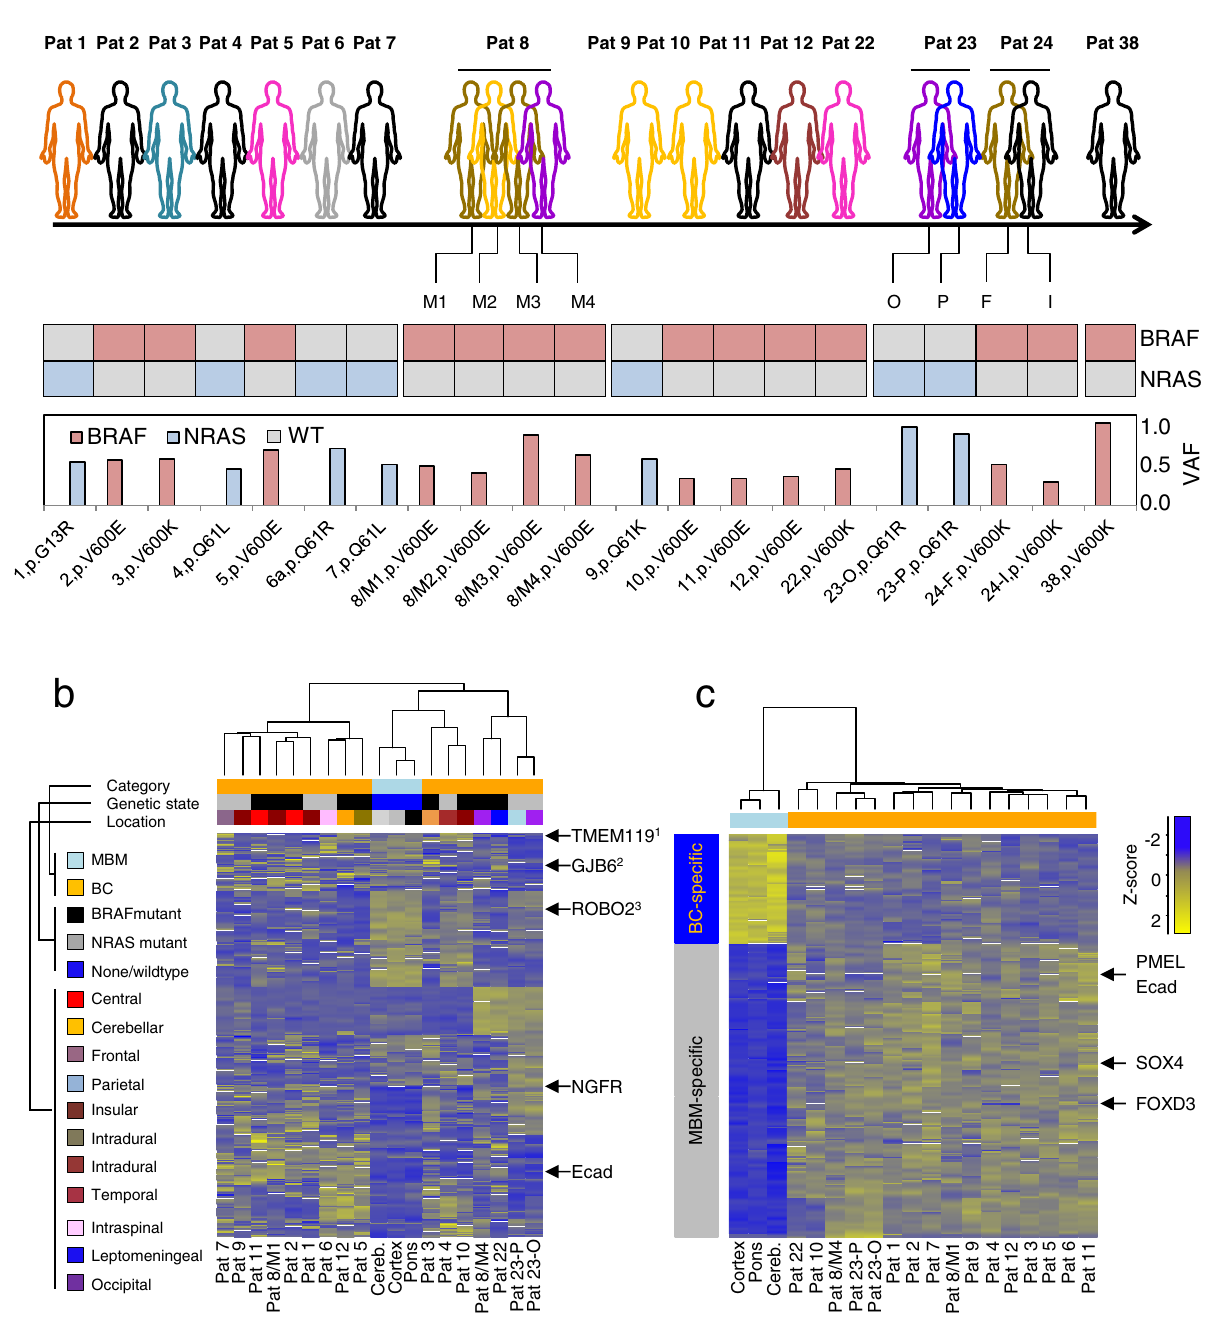
Fig. 2 | Characterization of melanoma brain metastases (MBM) revealed dif- ferent molecular subtypes. a Representation of the core study cohort, including MBM that have been pro fi led by RNAseq, 805k global methylome analysis and/or TargetSeq. Concordance(Pt.8,23, 24),intracranialsite of tumorsand the type and variant frequency (VAF) of BRAF/NRAS mutations is shown. b Unsupervised ana- lysis of the top1000 variably expressed genes among all MBM ( n =16), compared with brain controls (BC, n =3) revealed clustering independent from intracranial